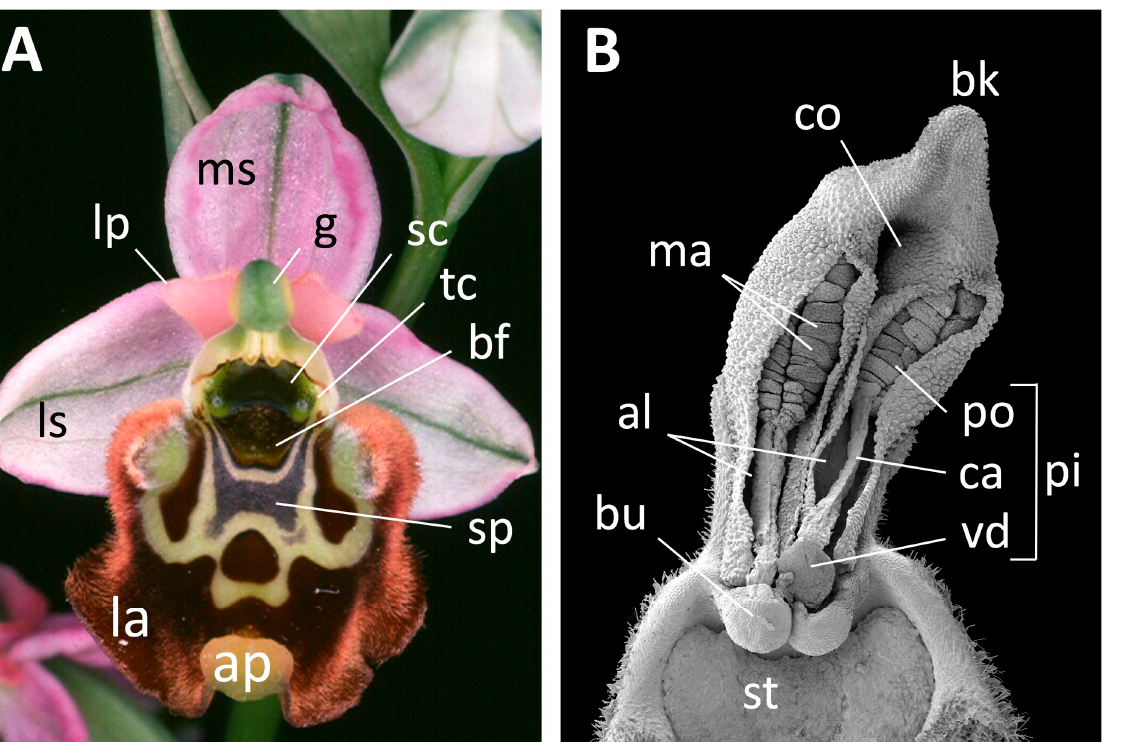
[43]. The complete morphometric matrix of 457 plants × 51 characters (total 23,307 cells) contained 4.4% (1026) missing values—a figure that fell to just 0.7% (120) if only the 39 floral characters were considered. The most frequent cause of missing values among veg- etative characters was the premature desiccation of the leaves, a phenomenon that affects plants growing in an unusually arid environment or sampled during an unusually arid spring (most commonly affecting macrospecies Sphegodes and Apifera).